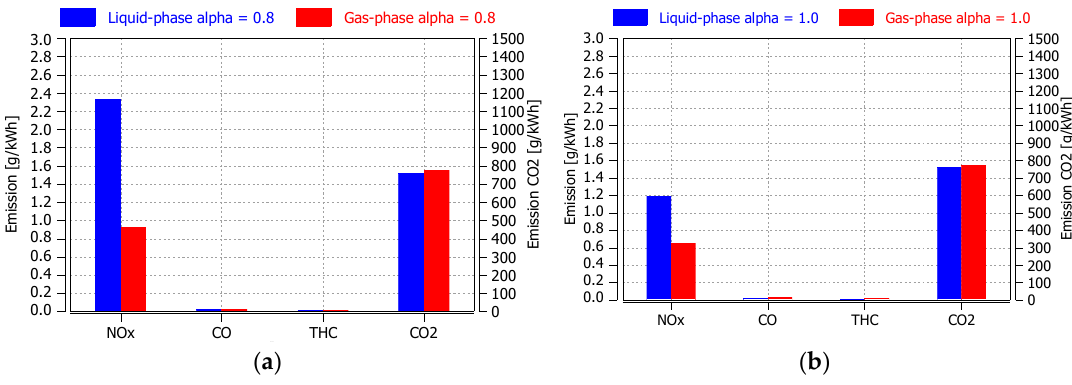
Figure 4. Emission results of gas and standard urea dosing at α = 0.8 ( a ) and α = 1.0 ( b ).